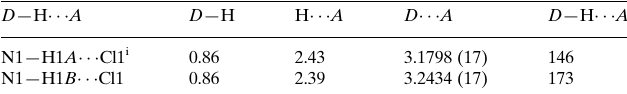
Hydrogen-bond geometry (A˚ , (cid:3)